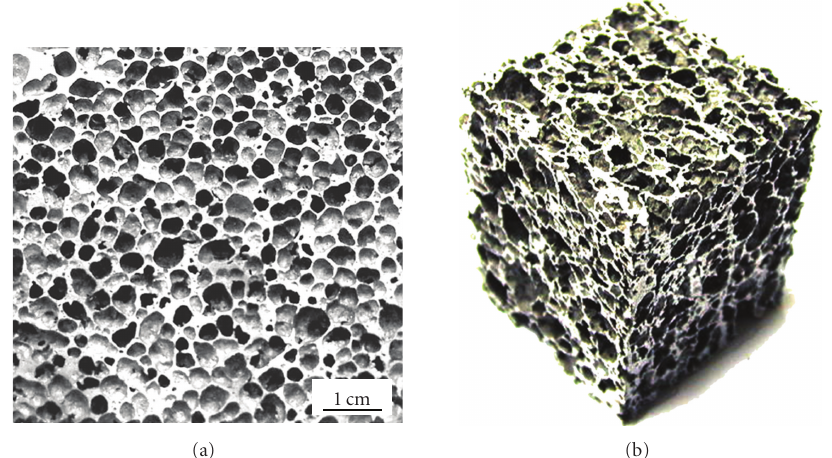
Figure 5: Digital optical image of (a) the cell morphology, and (b) isometric view (structure) of a typical Al-Si-Cu-Mg alloy